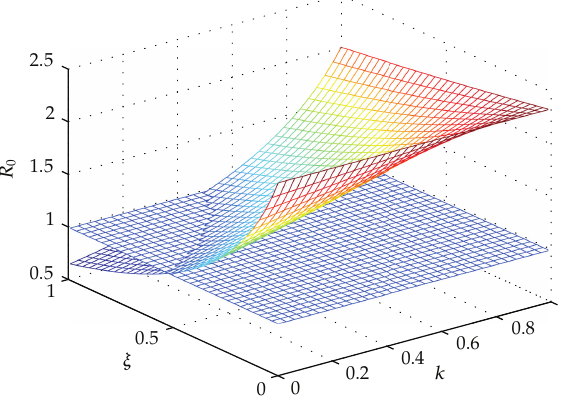
Figure 5: The relationship among R 0 , k and ξ